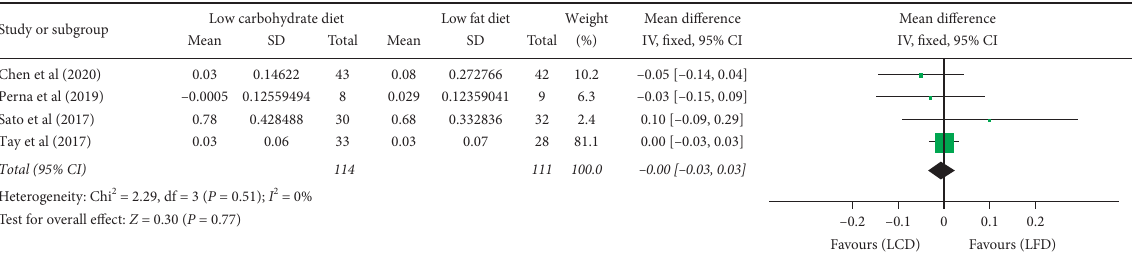
Figure 6: Forest plot for the effect of restriction diets on serum creatinine. LCD: low-carbohydrate diet; LFD: low-fat diet; CI: confidence interval; SD: standard